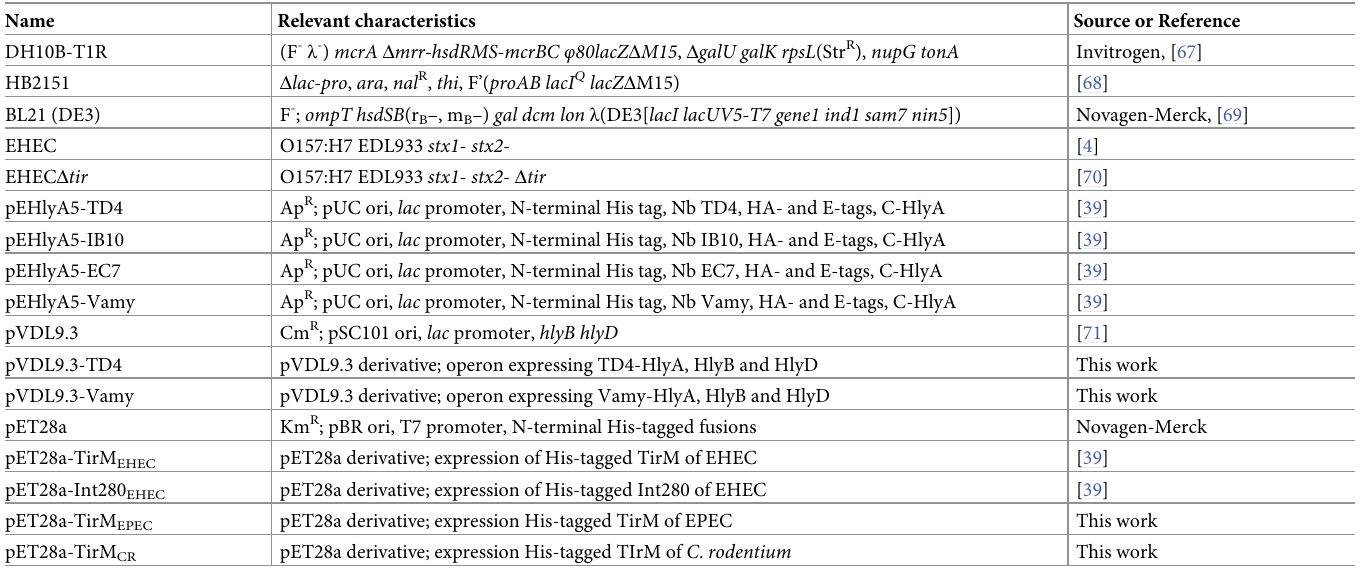
Table 1. Bacterial strains and plasmids used in this work.